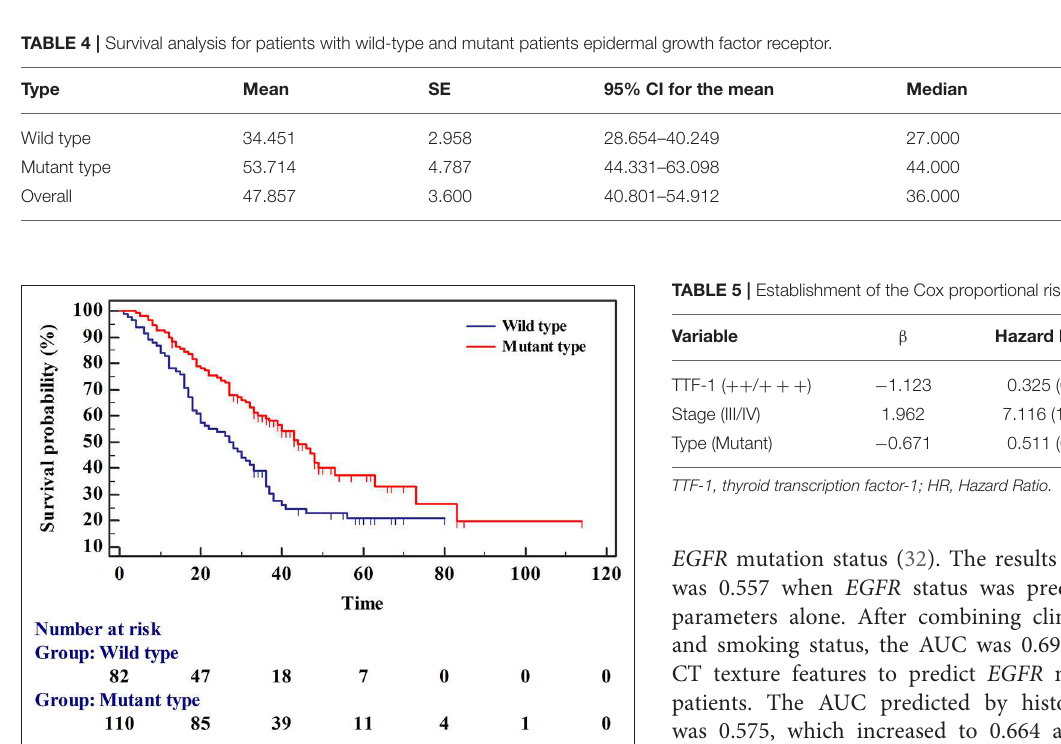
FIGURE 3 | Survival curves for patients with wild-type and mutant epidermal growth factor receptor.